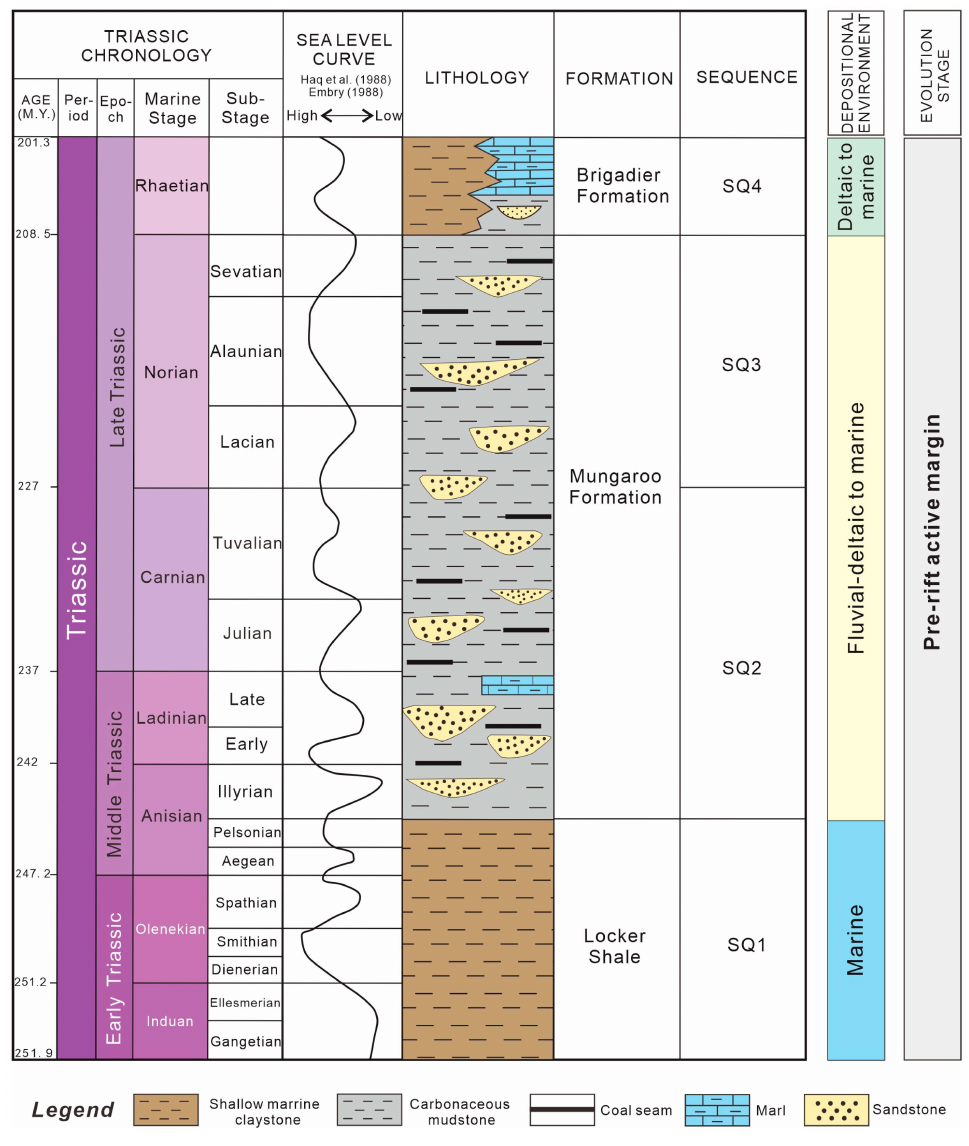
Figure 2. Stratigraphic map of the NCB, showing the Triassic chronology, sea-level curve, lithology, formation, sequences, depositional facies, and evolution stage. The major interval is the Triassic strata (especially the Mungaroo Formation) with a typical fluvial–deltaic to marine